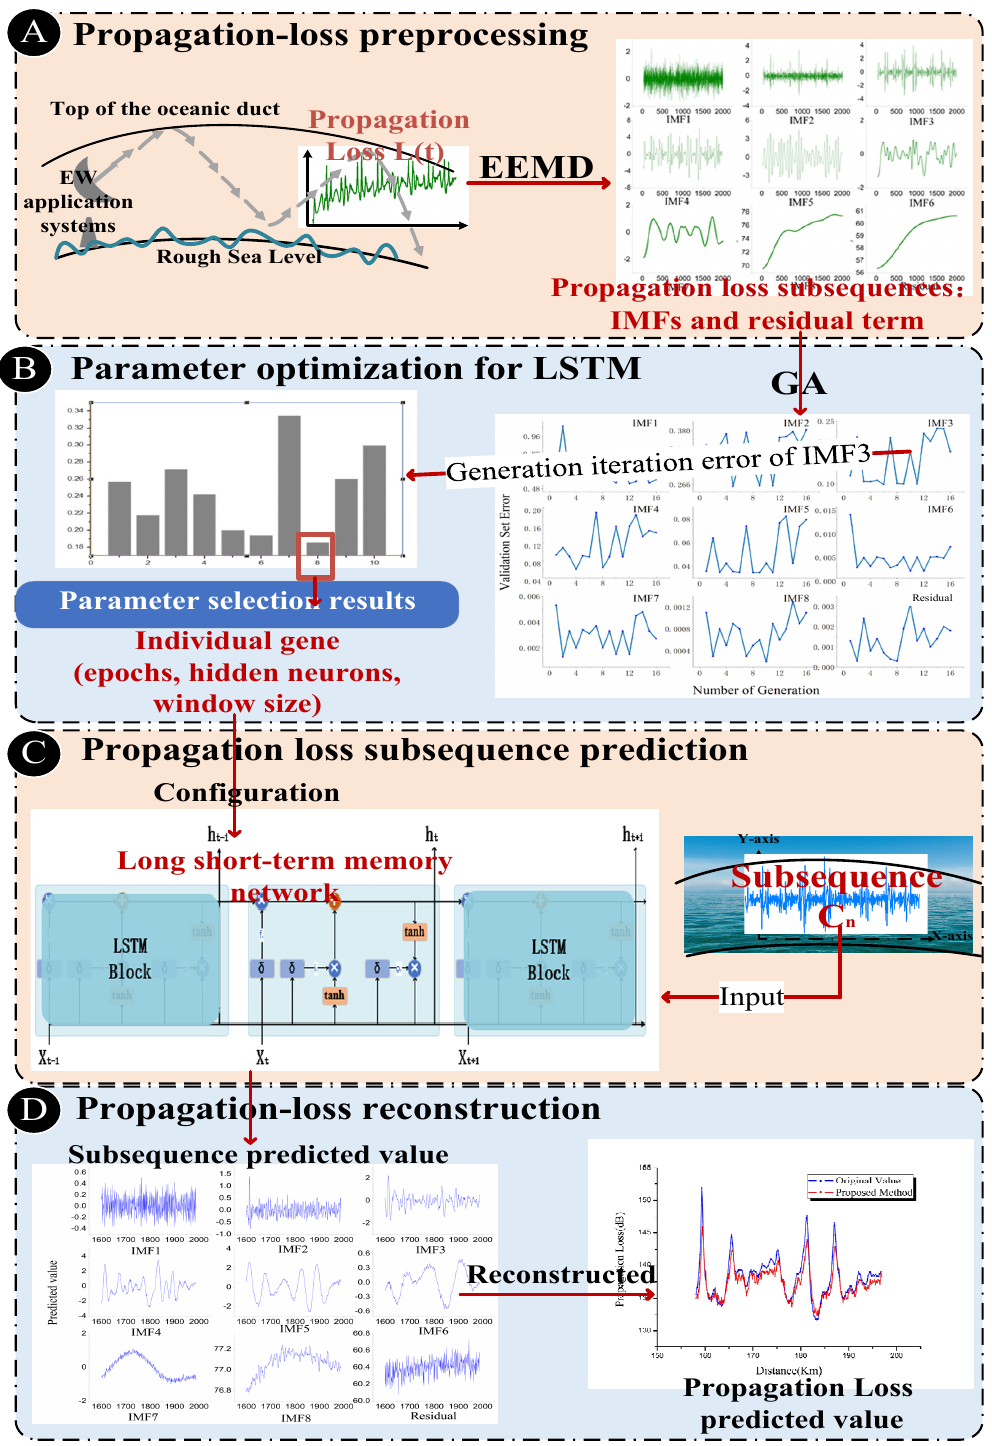
Figure 2. Flow chart of predicting propagation loss. ( A ) propagation-loss preprocessing; ( B ) parameter optimization for LSTM; ( C ) propagation-loss subsequence prediction; ( D )propagation-loss reconstruction.